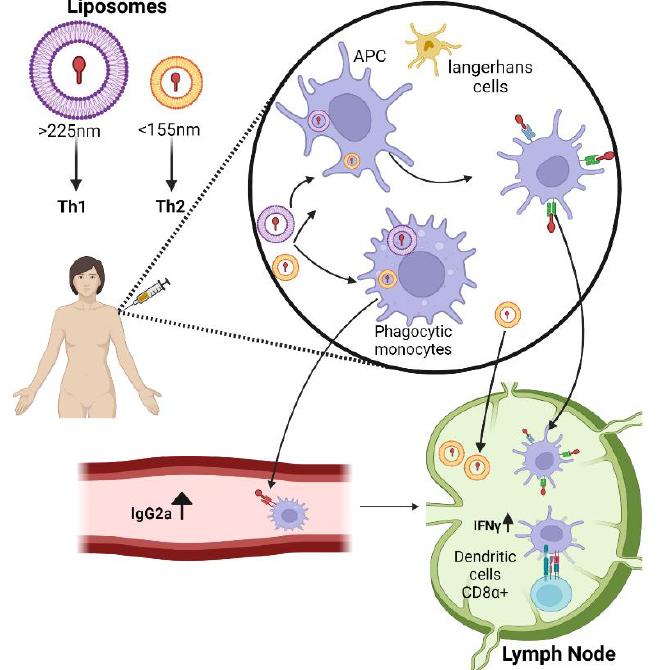
Figure 1. Nanoparticle trafficking from skin to draining lymph node in size-dependent manner. Large particles shuttle from the interstitial space through DC take up, involving activation of cell adhesion molecules, and inducing preferentially Th1 response (elevation of IgG2a in the plasma) and elevation of IFNγ in the lymph node. Small nanoparticles drain freely to the lymphoid node and induce Th2 response of increased IgG1 and IL5. Created with BioRender.com.